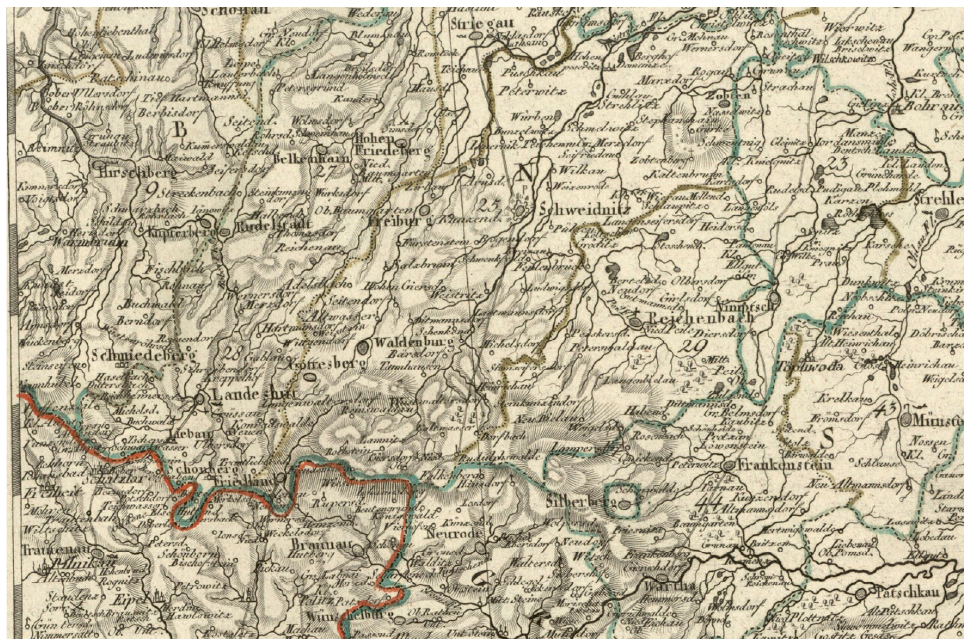
Fig. 3. Sections of West Sudetes and Middle Sudetes with Ślęża Massif and poorly visible Sudetes edge (fault) in F.A. Schrämbl’s world atlas from 1800. Relief presented with simple hachure. The edge of Sudetes on this map lies just next to Świdnica (Schweidnitz), while in reality it is located